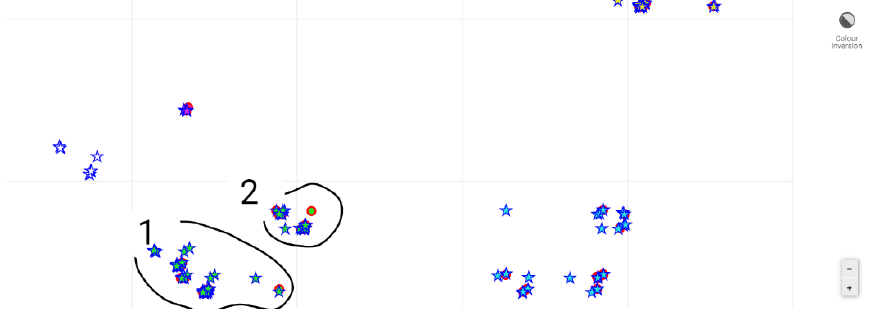
Figure 4. Sub-map of the AD population of Class V. This sub-map (zoomed in) provides another facet of the Alzheimer's